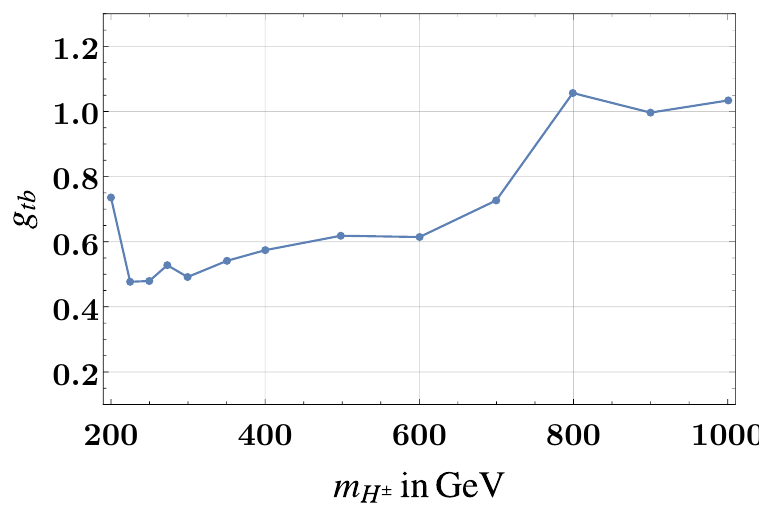
Figure 4 . 95% CL Bounds on charged Higgs couplings g tb from top production and decay derived from the ATLAS analysis in ref.